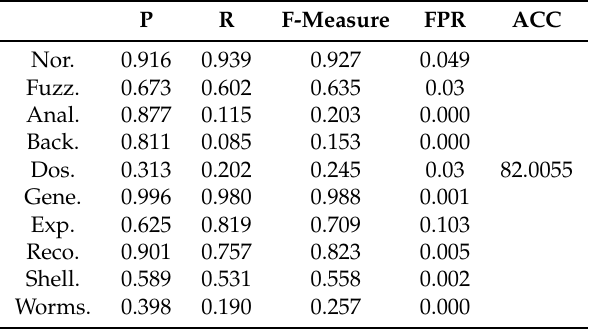
Table 12. Evaluation measures of normal and other types of attacks classification for UNSW-NB15 dataset. P R F-Measure FPR ACC Nor. 0.916 0.939 0.927 0.049 Fuzz. 0.673 0.602 0.635 0.03 0.877